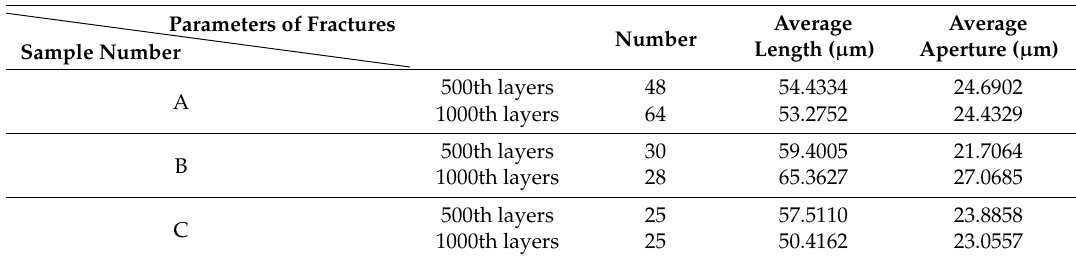
Table 3. Parameters for the fracture of oil shale after pyrolysis.